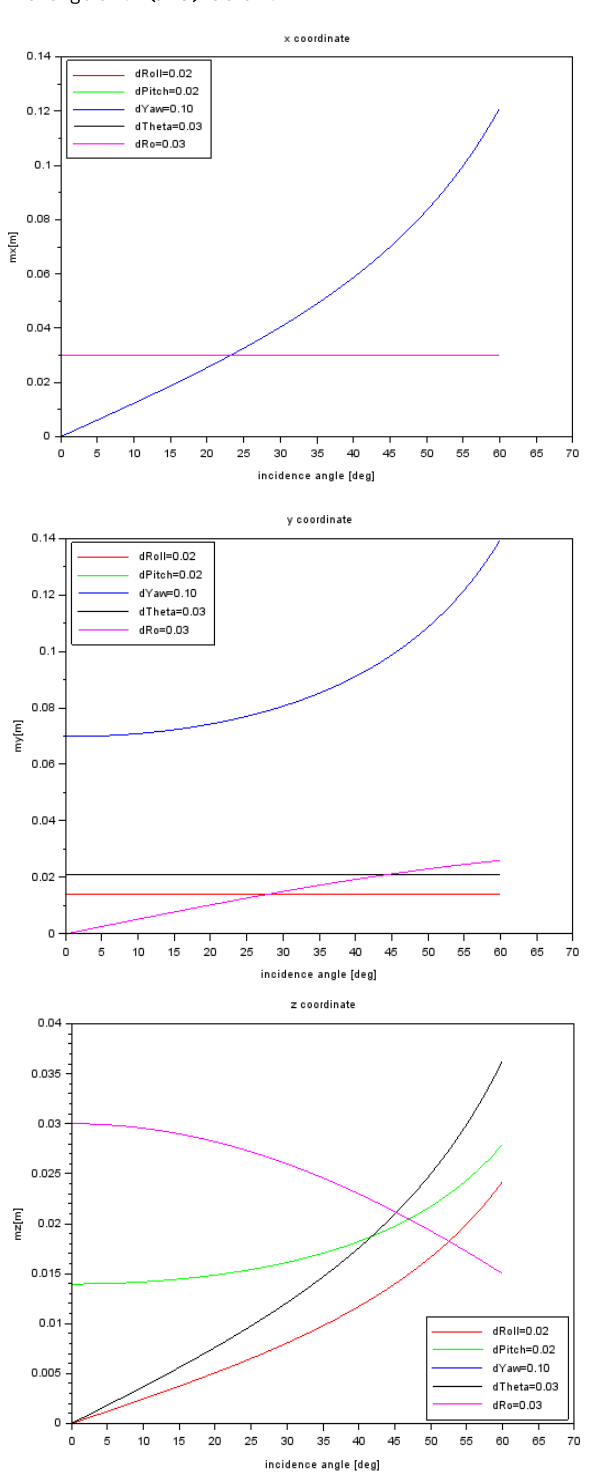
Figure 1. Effect of roll, pitch, yaw, theta and range errors on the x, y and z accuracies relating to the incidence angle